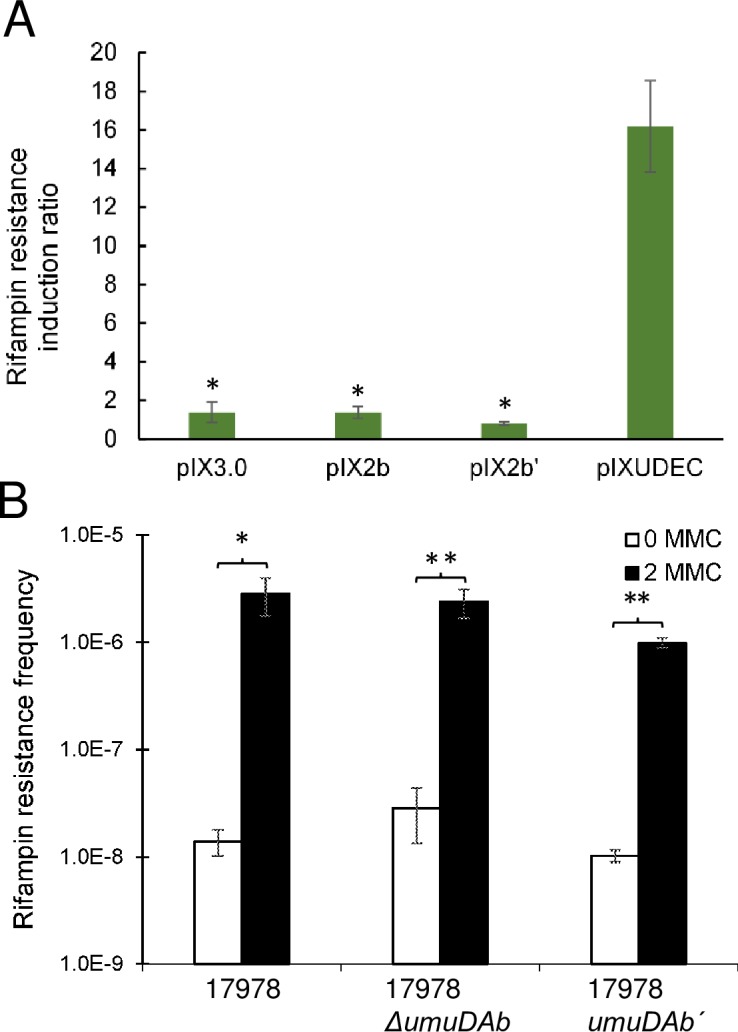
DNA damage-induced mutagenesis experiments suggest that UmuDAb does not perform UmuD polymerase accessory function.(A) DNA damage-induced mutagenesis (measured by, and represented as, the ratio of increased rifampin resistance observed in UV-treated vs untreated cells) was performed to assess whether umuDAb could complement an E. coli ΔumuD mutant. The E. coli ΔumuD772::kan strain 315 carried either: pIX3.0 (containing no DNA insert), pIX2b (pIX3.0 carrying A. baylyi umuDAb [20]), pIX2bˊ (pIX3.0 carrying A. baylyi umuDAbˊ (umuDAbΔ2–83), or pIXUDEC (pIX3.0 carrying E. coli umuD). Differences among strains were analyzed with a two-tailed, one-way Kruskal-Wallis ANOVA, followed by Dunn’s multiple comparisons post-test indicating significance denoted by * (p < 0.05 when compared to the vector carrying E. coli umuD). (B) No reduction in the induced rifampin resistance was observed in the presence of DNA damage in A. baumannii ΔumuDAb or umuDAbˊ (umuDAbΔ2–83) cells, relative to wild type cells (p < 0.05). Data are represented as the average of a minimum of four (panel A) or six (panel B) experiments with error bars representing the standard error of the mean.